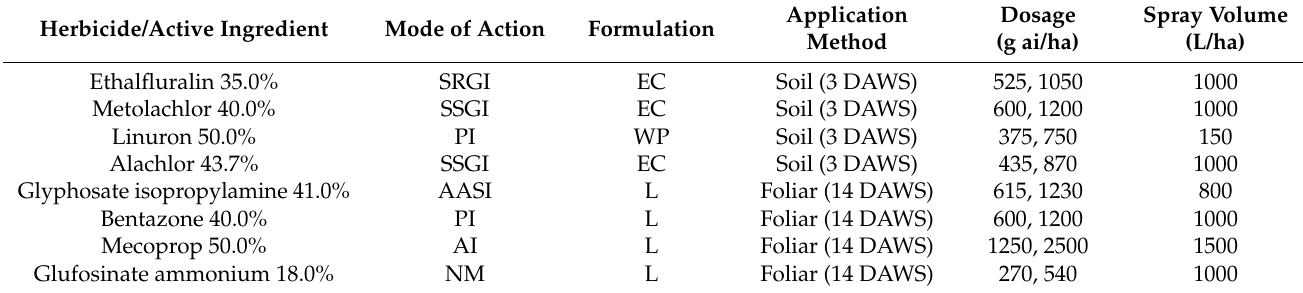
Table 1. Active ingredients used in this